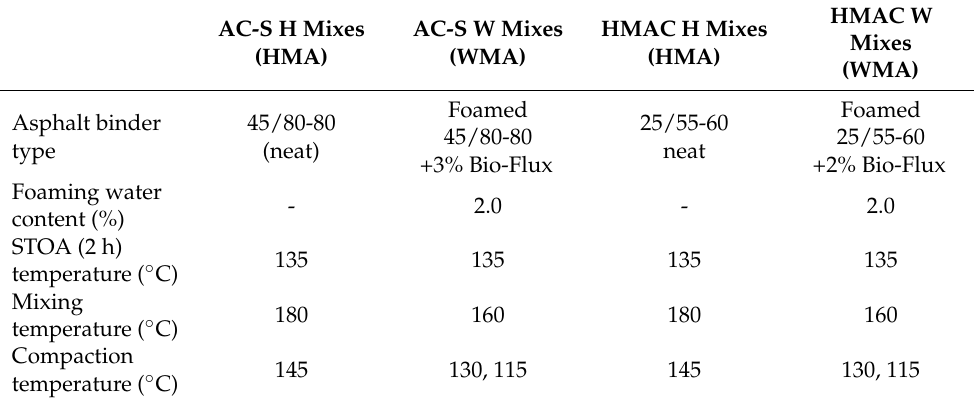
Table 3. Processing details of the investigated asphalt